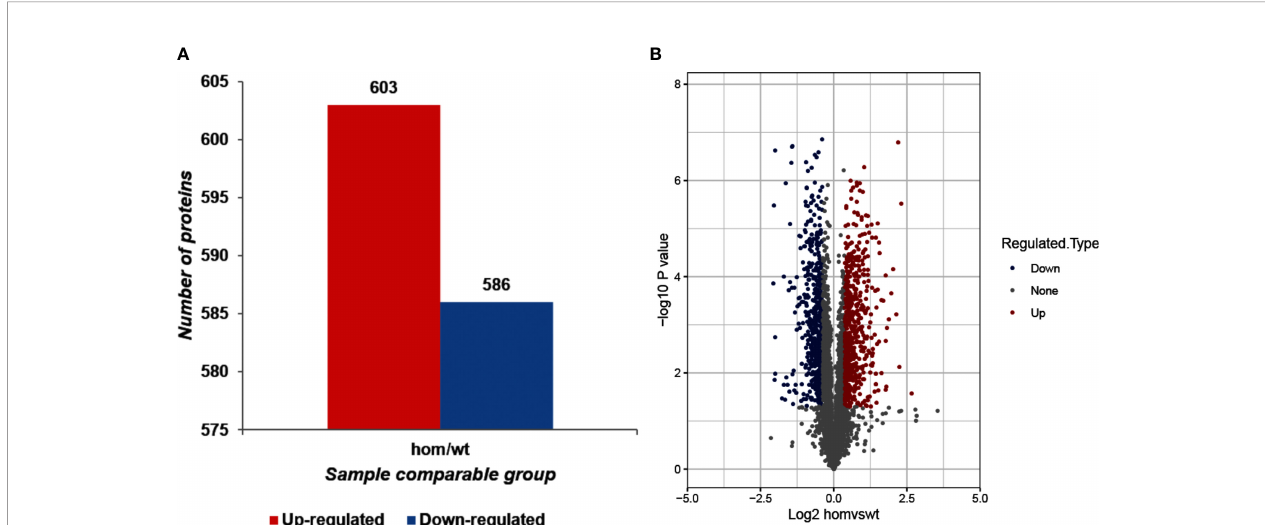
FIGURE 2 | Identi fi cation of differentially expressed proteins (DEPs) between Thra E403X/E403X and Thra +/+ mice. (A) The total number of upregulated and downregulated DEPs. The fold change (FC) >1.30 and p -value <0.05 were set as the signi fi cant thresholds for the upregulated DEPs. FC <0.77 and p -value <0.05 were set as the signi fi cant thresholds for the downregulated DEPs. (B) Volcano plot of the identi fi ed DEPs between Thra E403X/E403X ( n = 5) and Thra +/+ ( n = 4) mice. The x-axis shows the log2 fold change of each protein, and the y-axis shows the p -value of the signi fi cant difference test after log10 logarithmic conversion. The red dots denote upregulated DEPs, the blue dots denote downregulated DEPs, and the gray dots denote unchanged